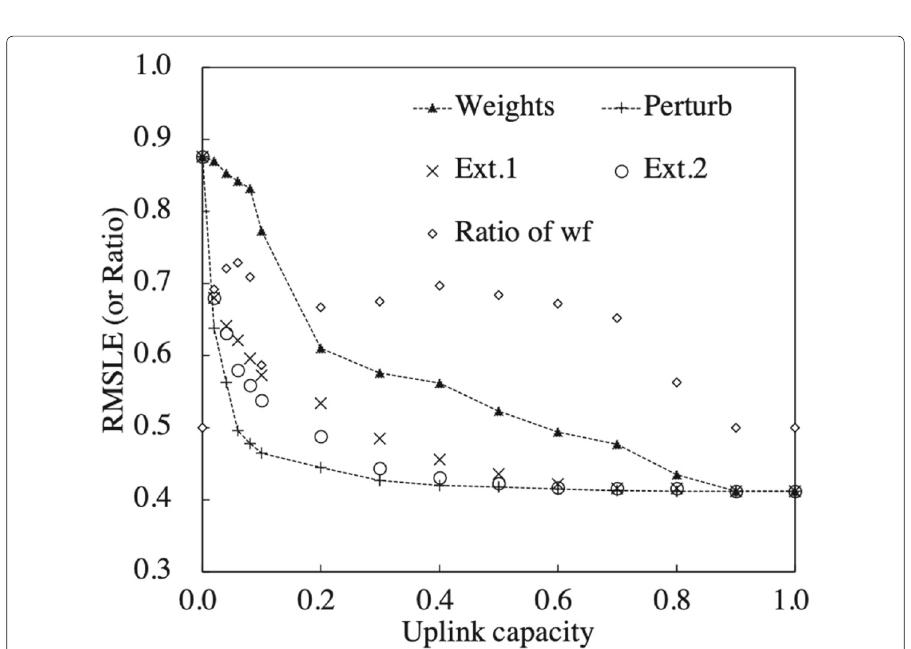
Fig. 11 Prediction accuracy (RMSLE) vs. uplink capacity obtained using MLP for prediction. Perturb, weights, extension scheme 1 with ranking, or extension scheme 2 were used for feature selection. Ratio of w f for perturb to other in extension scheme 2 is also